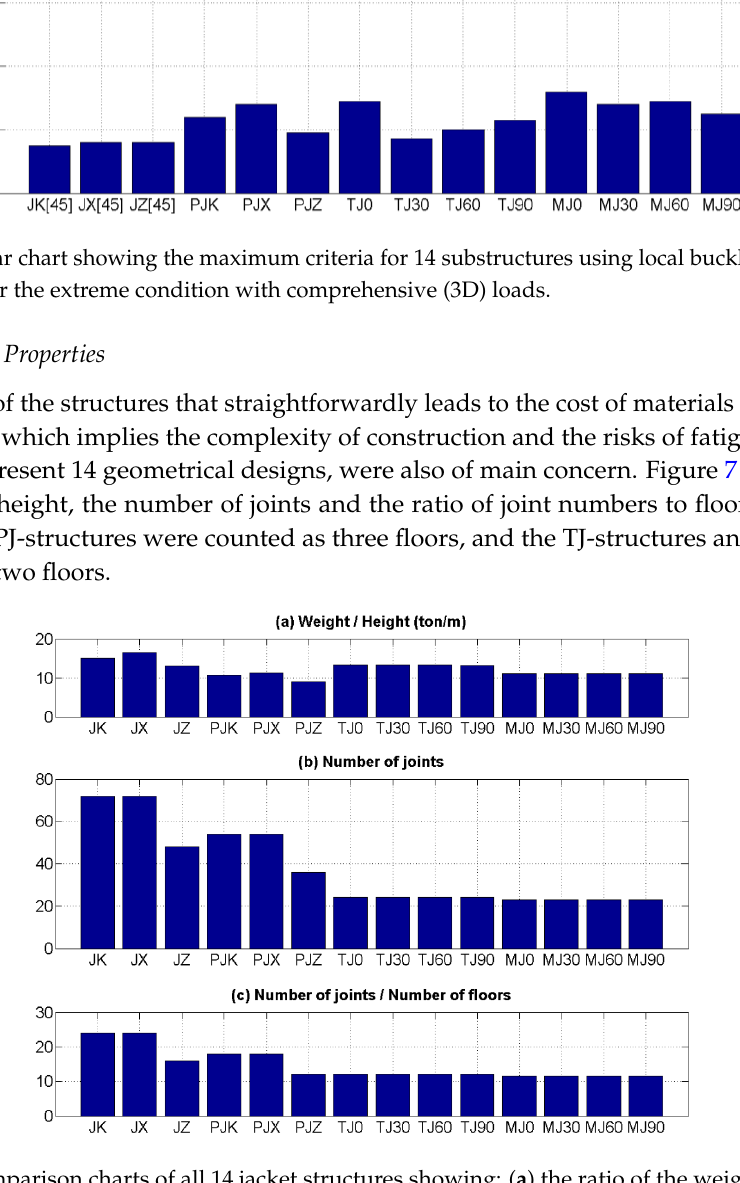
Figure 6. A bar chart showing the maximum criteria for 14 substructures using local buckling strength analysis under the extreme condition with comprehensive (3D) loads.